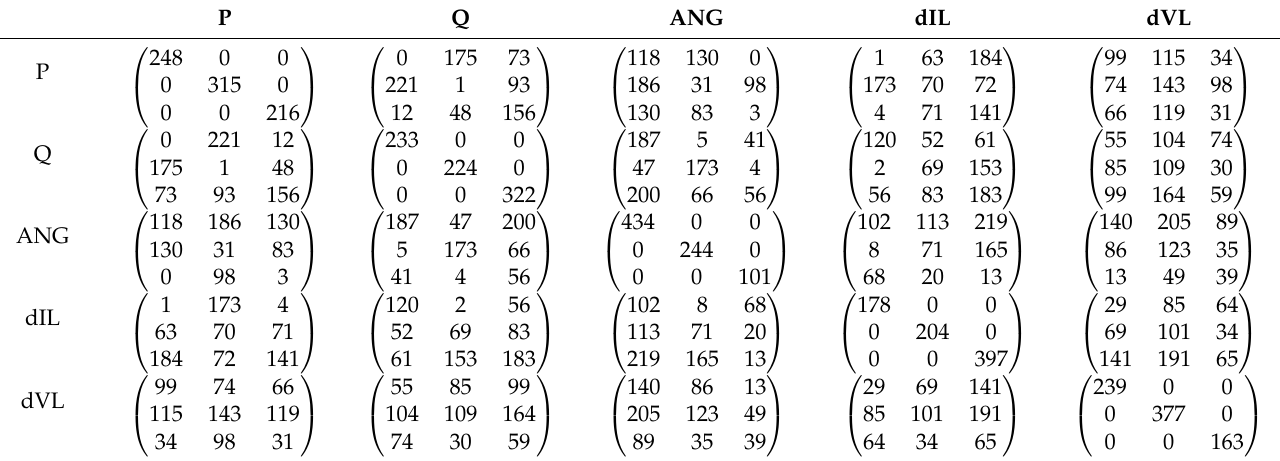
Table 4. Coincidence table between classifications. Scenario